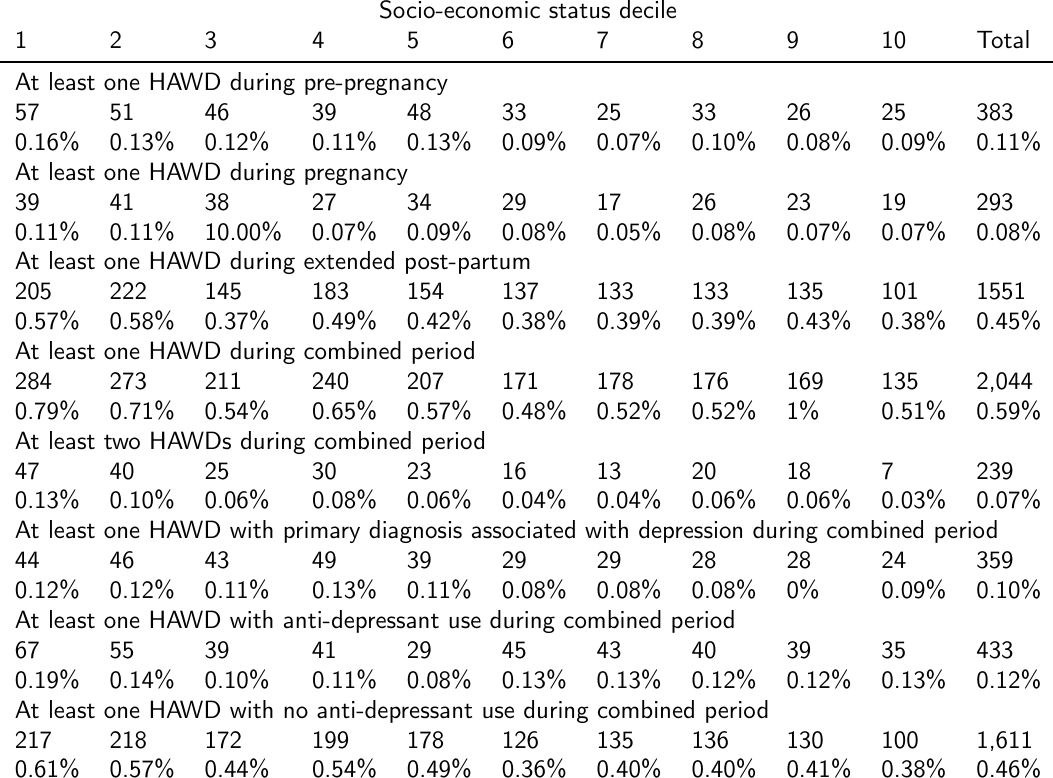
Table 2: Numbers and percentages of hospitalizations (medical or psychiatric) associated with a HAWD by SES Socio-economic status